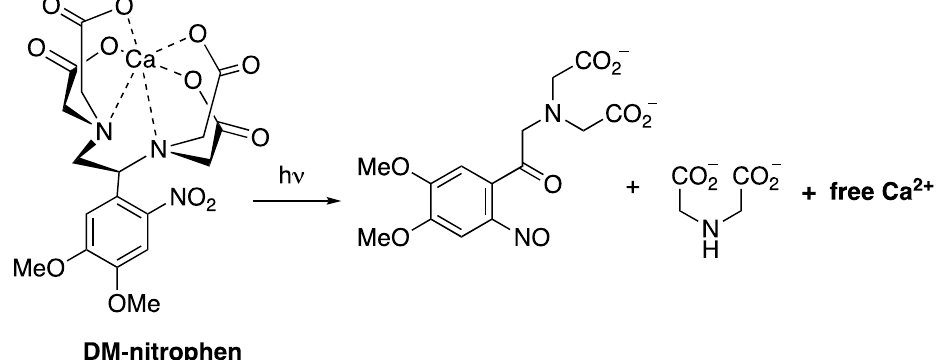
Figure 1. Photolysis of DM-nitrophen, resulting in a major structural change with a Ca 2+ release.